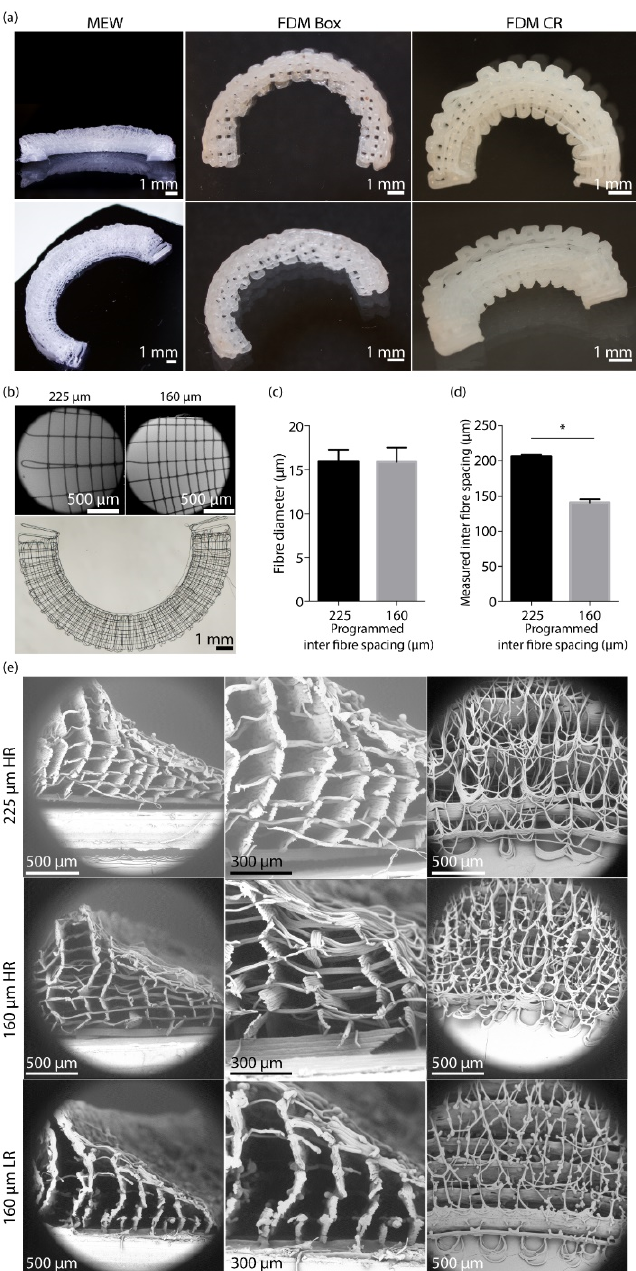
Figure 1. Printability of circumferential and radial melt electrowritten fibres to achieve a wedge shaped meniscus. ( a ) Macroscopic image of Melt electrowritten (MEW) scaffold, Fused deposition Modelling ( FDM) scaffold with an inner boxed-shaped (Box) architecture, and FDM scaffold with an inner circumferential/radial (CR) architecture. ( b ) Top view of a single layer of circumferential and radial fibres. ( c ) Fibre diameter of fibres for both inter fibre spacings ( n = 3 per group). ( d ) Measured inter fibre spacing for both programmed inter fibre spacings ( n = 3 per group). ( e ) Scanning electron microscopy images of scaffolds with both inter fibre spacings and the different ratios of circumferential and radial fibres. * = p < 0.05. Abbreviations; HR: high ratio of radial fibres, LR: low ratio of radial fibres.